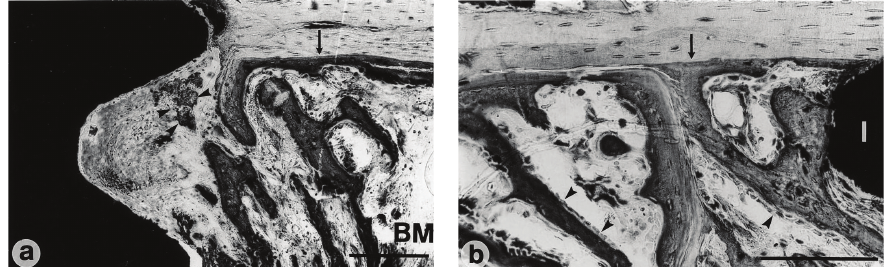
Figure 4: ((a), (b)) Solitary osteoid formation is found within the threads of the implant (arrow-heads). (a) Endosteal trabeculae in the bone marrow (BM) are protruding towards the implant surface. The border between the “old” cortex and the newly formed bone (arrows) is clearly visible. Bar = 200 𝜇 m. (a) Machined (control) sample and (b) glow discharge cleaned and thermally oxidized sample. one week after implantation. The osteoblasts are lining the newly formed trabeculae (arrow heads). Bar = 200 𝜇